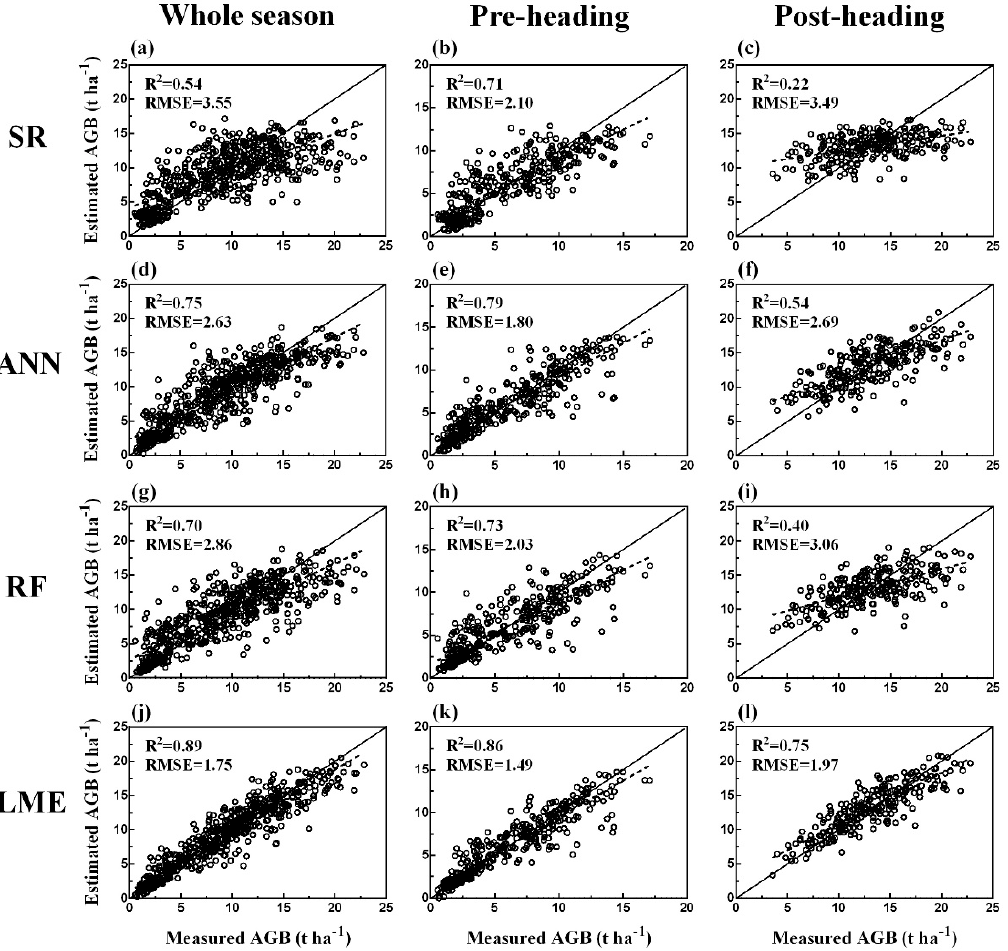
Figure 7. Validation of above ground biomass (AGB) estimation models for the whole season and